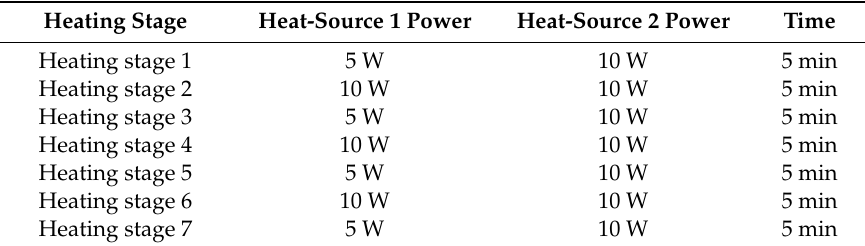
Table 3. Variable powers at different stages.